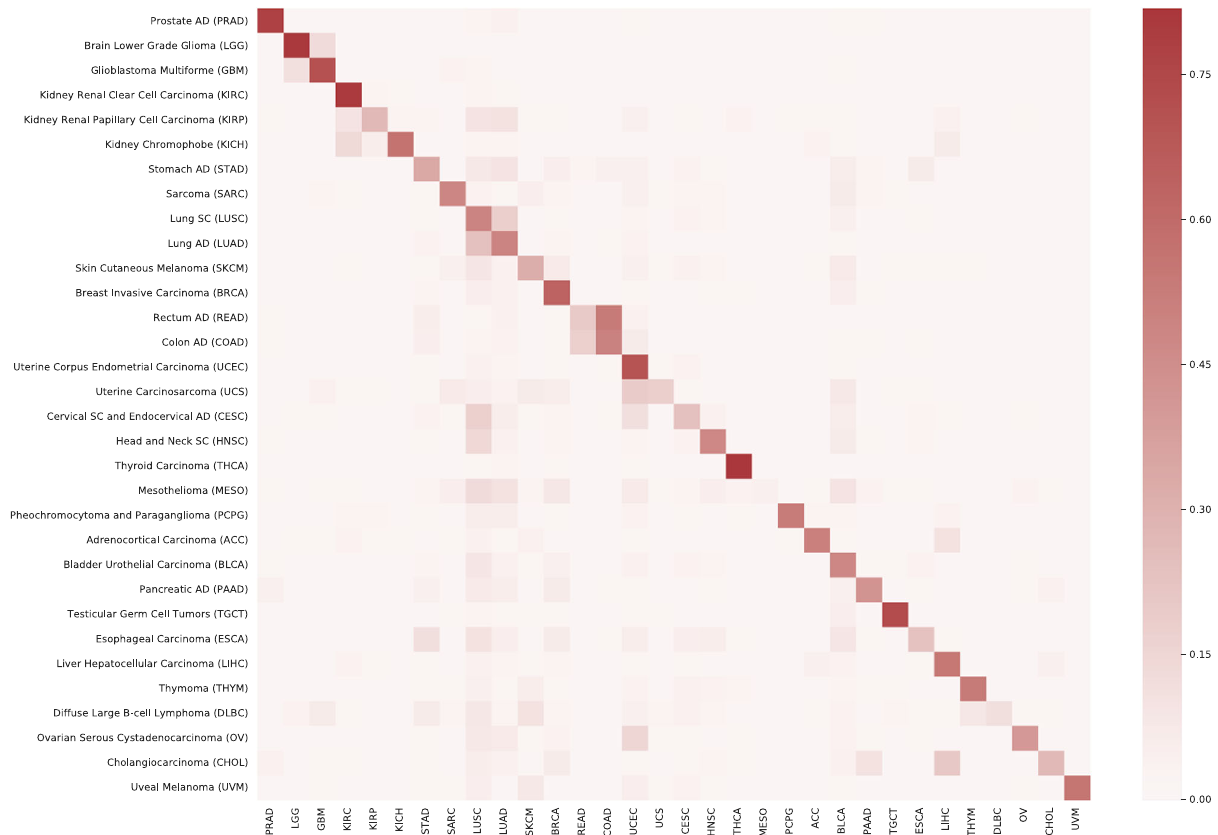
Fig. 6 Heatmap of re-scaled relative frequency of matched (red) and mismatched (pale) search results for each diagnosis from permanent diagnostic slides. Re-scaling of frequencies was done through dividing each frequency by the total number of slides for each